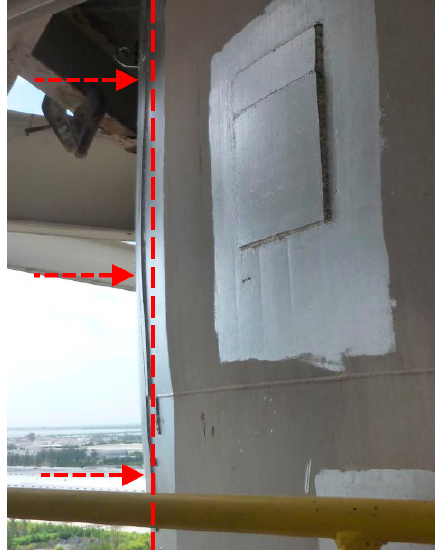
Figure 3. Plastics deformations.